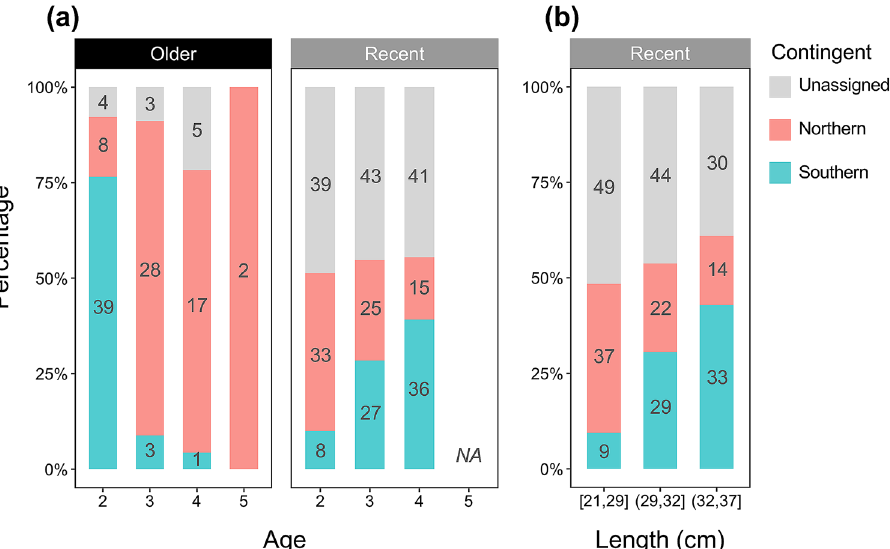
Figure 5. Contingent composition of Northwest Atlantic mackerel age ≥ 2 adult samples across ( a ) age class for older (1998–2000) and recent (2011–2016) year-classes, and ( b ) size class (cm) for the recent year-class samples. Numbers in each bar plot indicate the sample size of northern and southern contingents, and unassigned fish (probability < 0.7) for each age and size